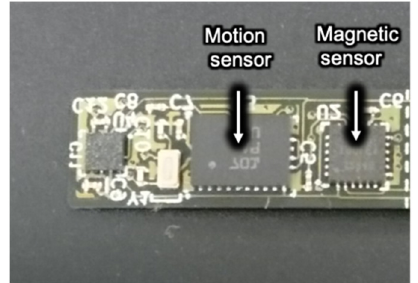
Figure 6. Photograph of the sensor module, including a magnetic and a motion sensor.